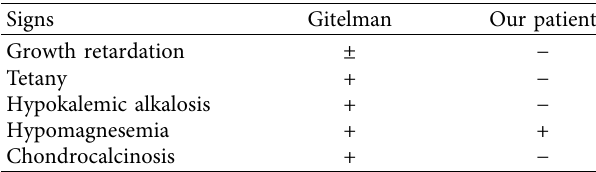
Table 2: Signs in typical GS cases and our